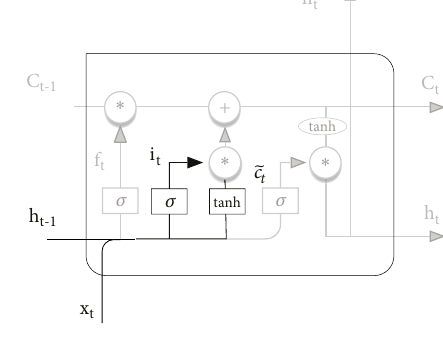
Figure 2: LSTM status update